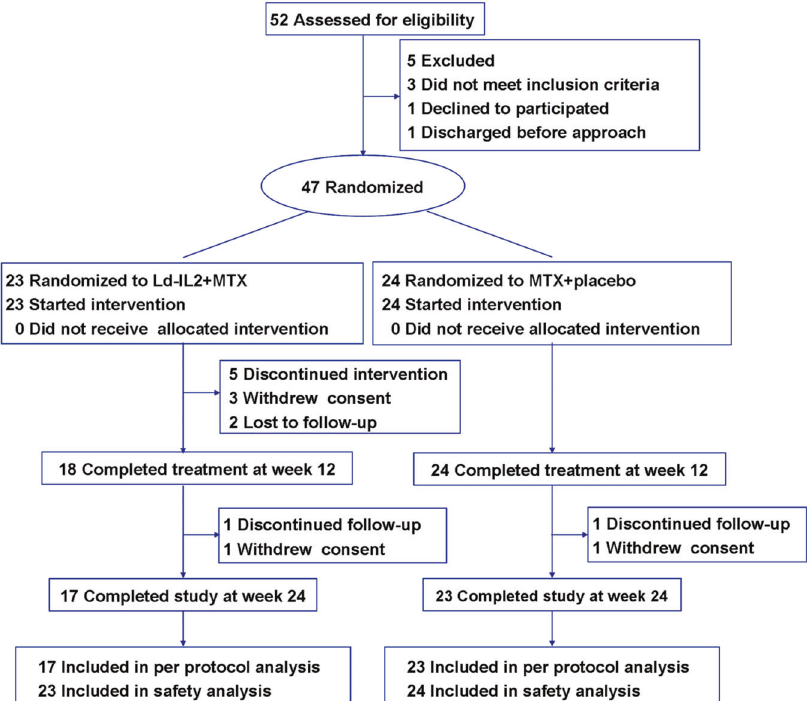
Fig. 1 Consort fl owchart of the study. Of the 47 randomized patients, 23 were exposed to Ld-IL2 (de fi ned as a dose of 1 million IU) and 24 were exposed to placebo. All patients received methotrexate with Ld-IL2 or placebo. Ld-IL2 low-dose interleukin-2, MTX